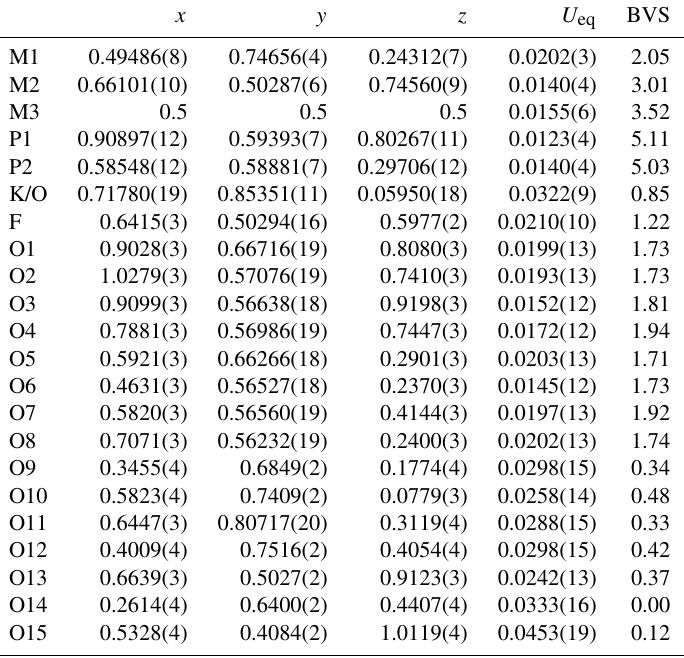
Table 4. Atom coordinates, equivalent isotropic displacement parameters (Å 2 ) and bond-valence sums (BVSs) for